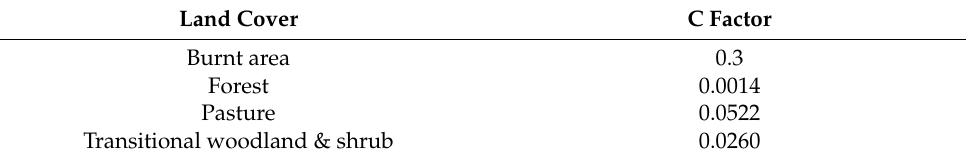
Table 2. C factor values per land-cover type for the study proposed by Panagos et al., 2015 [88]. Land